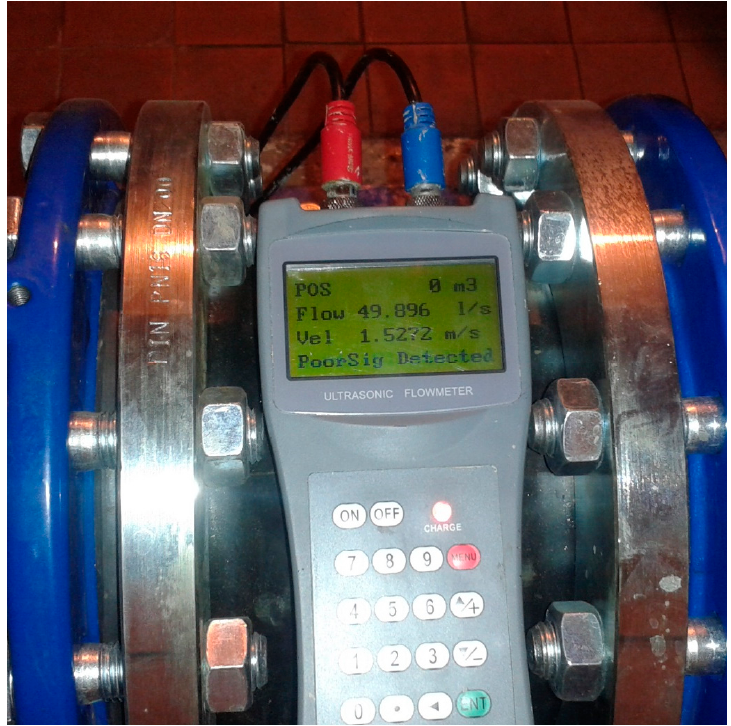
Figure 9. Portable ultrasonic flowmeter TDSH100.